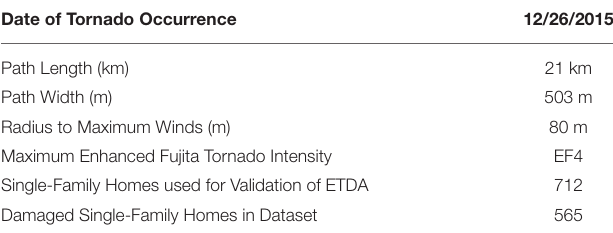
TABLE 3 | Characteristics of the Garland/Rowlett TX